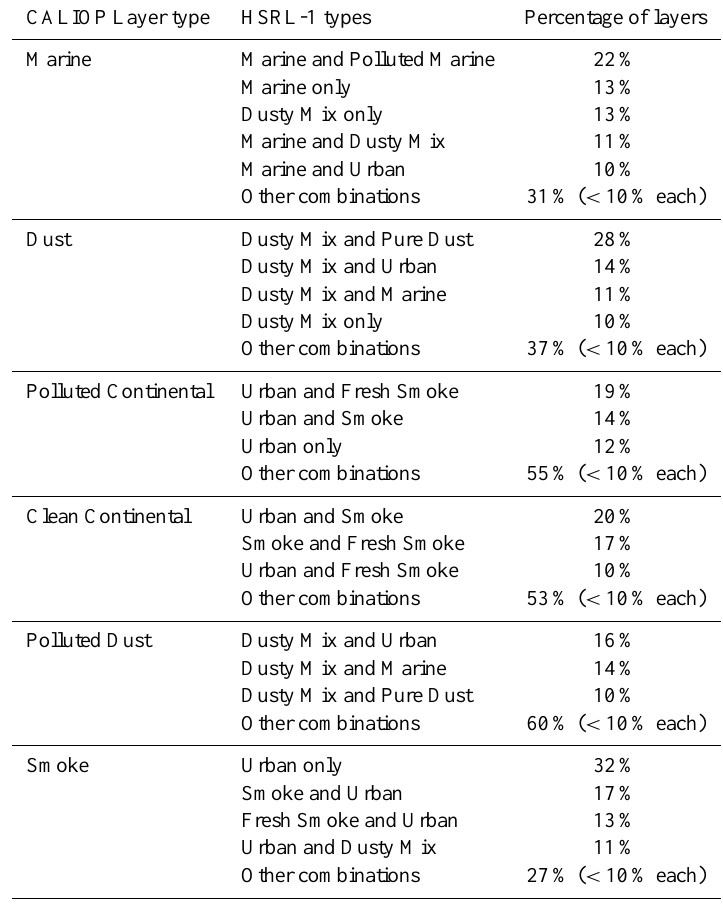
Table 2. The most frequent combinations of HSRL-1 types within CALIOP layers of a given type are listed. When more than one HSRL-1 type contribute to make up 90% of the AOT within a layer, the top two contributing HSRL-1 types are given.